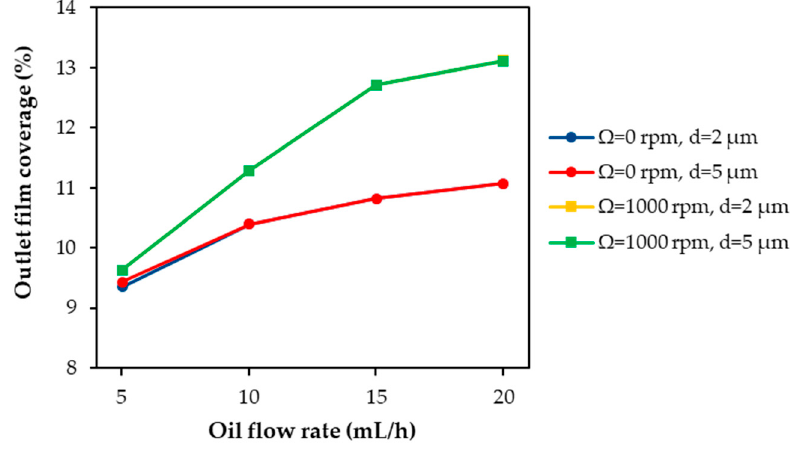
Figure 7. Film coverage at the outlet section as a function of the oil flow rate: each curve corresponds to one of the four possible combinations of the values of the drill bit rotational speed Ω and oil droplet diameter d at the channel inlet.